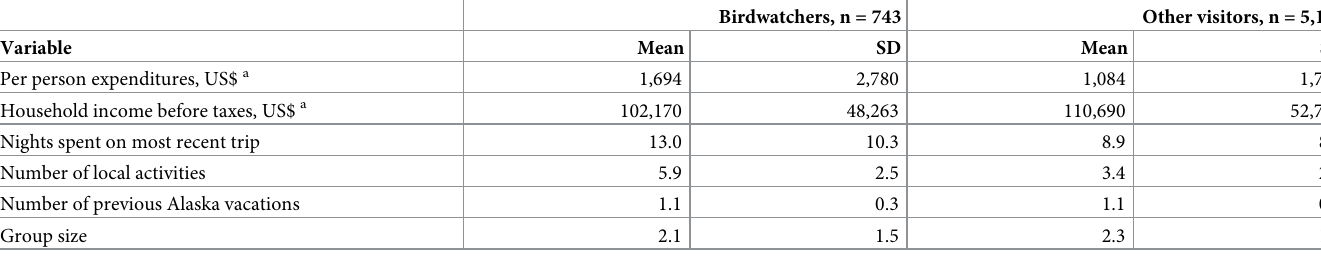
Table 2. AVSP survey respondent characteristics, 2016.